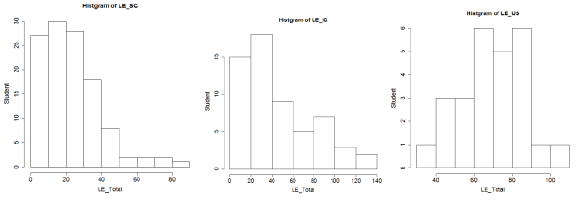
Figure 7. Histogram of Conscientiousness in each course (left: SDC, center: ITC, right: